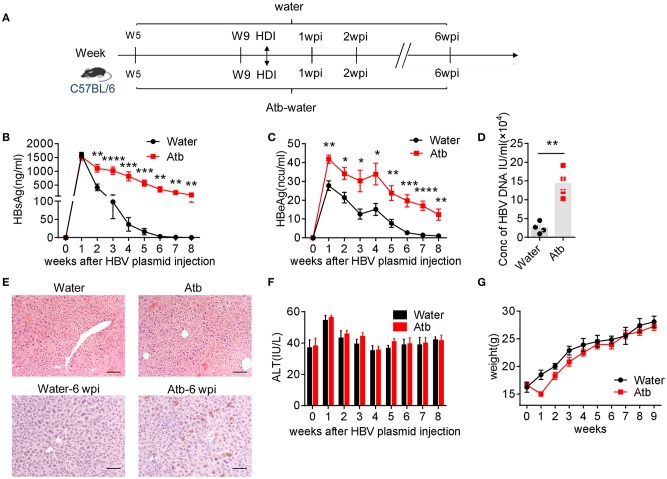
Microbiota depletion delayed HBV clearance. (A) Five-week-old B6 mice were divided into two groups: Atb-free and Atb-treated. Mice underwent HDI with 6 μg of HBV plasmids after treatment with Atb-treated water or Atb-free water for 4 weeks. Serum levels of HBsAg (B) and HBeAg (C) were assessed by immunoradiometric assay at the indicated time points. (D) Serum HBV DNA titers were assessed by quantitative real-time PCR at 4 weeks post-injection (wpi) (each point represents one mouse). (E) HBcAg+ hepatocytes (bottom) in liver tissue were detected by immunohistochemical (IHC) analyses at 6 wpi; H&E staining (top) of samples from Atb-free and Atb-treated mice at time point 0 (at injection) were shown. Scale bar, 50 μm. (F) Serum alanine aminotransferase (ALT) levels were quantified using an automated Chemray 240 clinical analyzer at the indicated time points. (G) Body weights were recorded at the indicated time points. The data are representative of more than three independent experiments. Results are presented as the mean ± SEM (n ≥ 4 mice/group) and unpaired two-tailed Student's t-tests were used. *p < 0.05, **p < 0.01, ***p < 0.001, ****p < 0.0001.